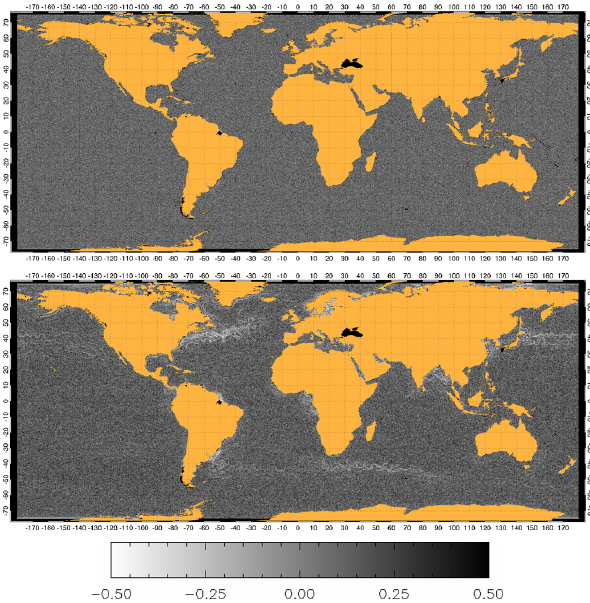
Fig. 8. Top: Singularity exponents associated with SSS after noise of unity amplitude and β = 0. Bottom: Singularity exponents de- rived from the fused SSS map.